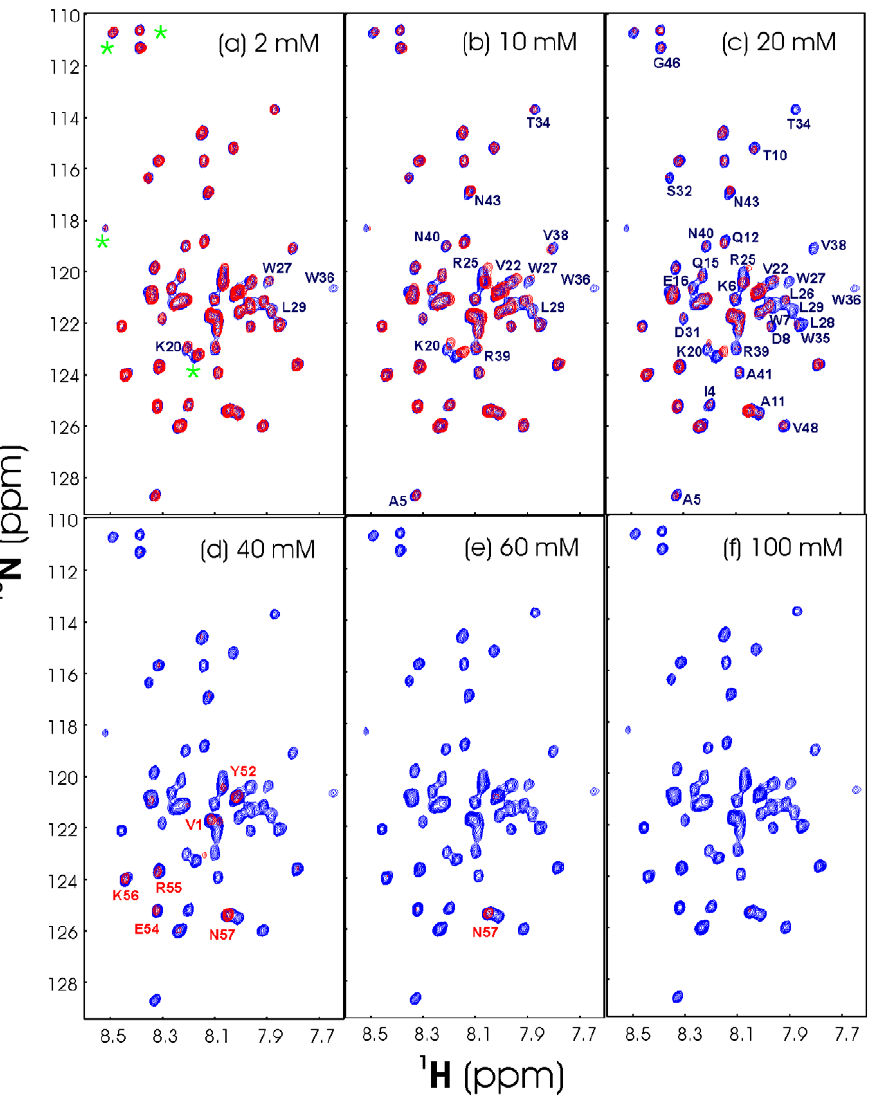
Figure 10. Salt titrations as monitored by HSQC. Superimposition of the 1 H- 15 N NMR HSQC spectra of V22-SH3 at a protein concentration of , 50 m M, solubilized in salt-free water (pH 4.0) (blue), and with additional introduction of NaCl (red) to 2 mM (a); 10 mM (b); 20 mM (c); 40 mM (d); 60 mM (e); and 100 mM (f). The HSQC spectra were acquired on an 800 MHz NMR spectrometer at 25 u C. The blue font is used for labelling the residue with its HSQC peak intensity significantly reduced or disappeared, while the red is for the residue with its HSQC peak still observed. *: HSQC peaks resulting from the residues located on the His-tag.